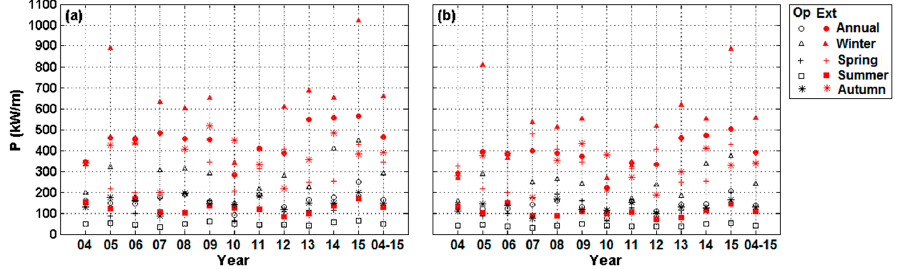
Figure 20. Annual and seasonal operational (Op) and extreme (Ext) P thresholds (kW/m) at ( a ) BA and ( b ) BB.